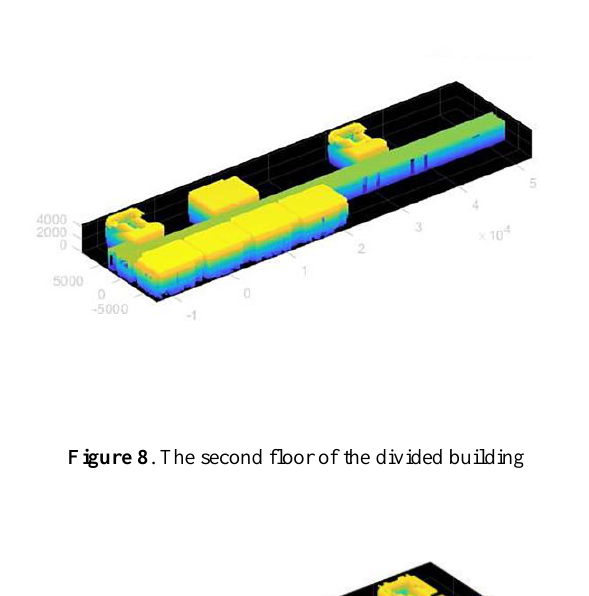
Figure 11 . Wall line point cloud